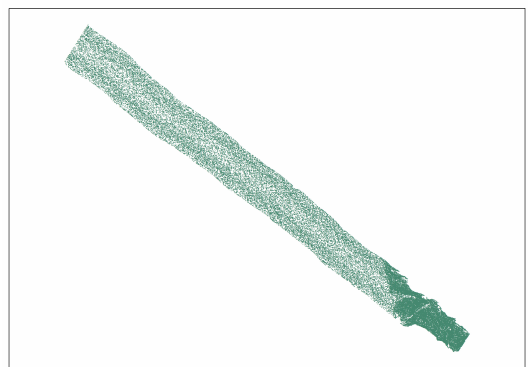
Figure 17. DDR thinning method of 11% thinning rate